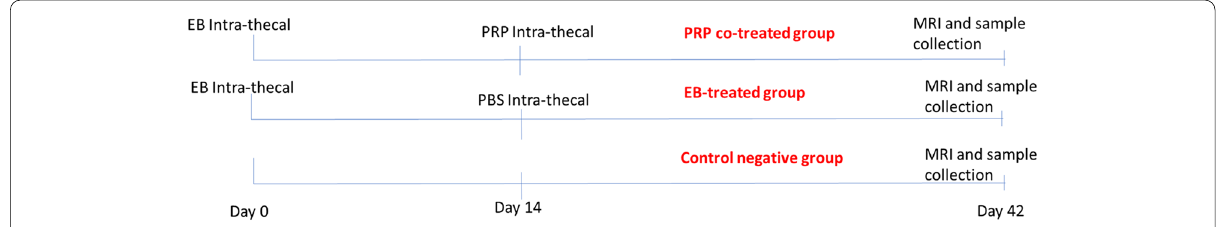
Fig. 1 Diagram showing the timeline of the treatment